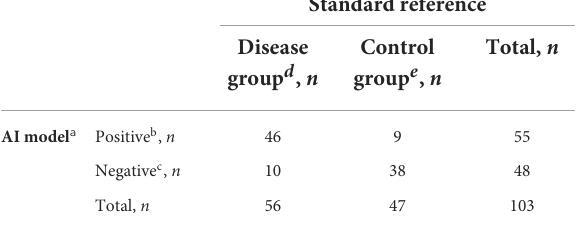
TABLE 2 Performance metric sensitivity,